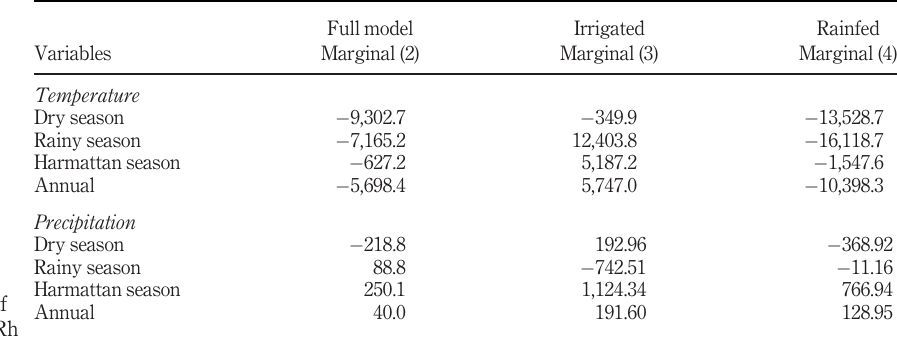
Full model Irrigated Rainfed Variables Marginal